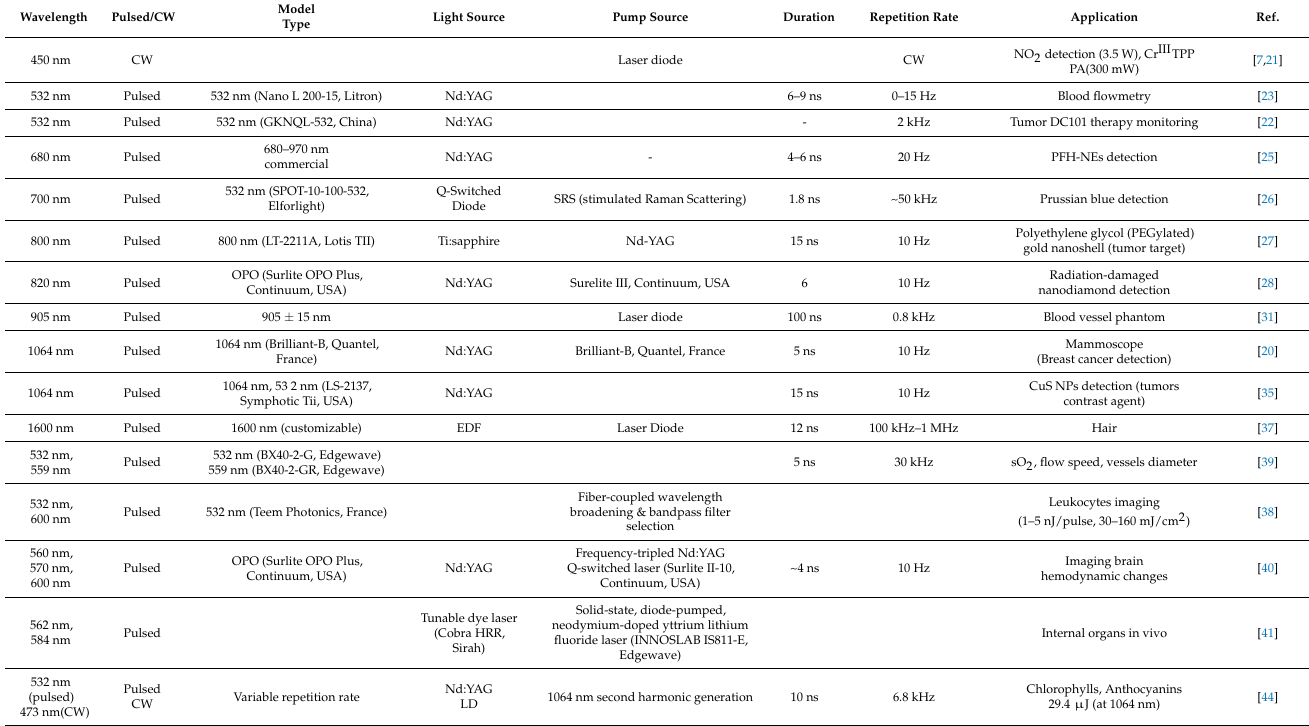
Table 1. Optical source wavelengths for photoacoustic